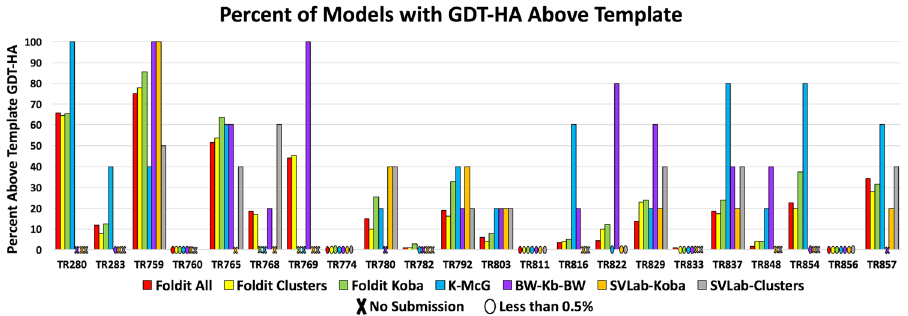
Figure 8. Chart comparing the percentage of models in each step of the refinement pipeline that improved the GDT_HA of the original model provided by CASP organizers. The steps are identified as follows: (1) models generated by Foldit players (Foldit-All), (2) clusters (Foldit Clusters), (3) clusters refined by KoBaMIN (Foldit Koba), (4) selection by McGuffin (K-McG), (5) selection by Wallner/ProQ2 (BW-Kb-BW), (6) selection by SVLab of KoBaMIN-refined clusters (SVLab-Koba), and (7) selection by SVLab based on unrefined clusters